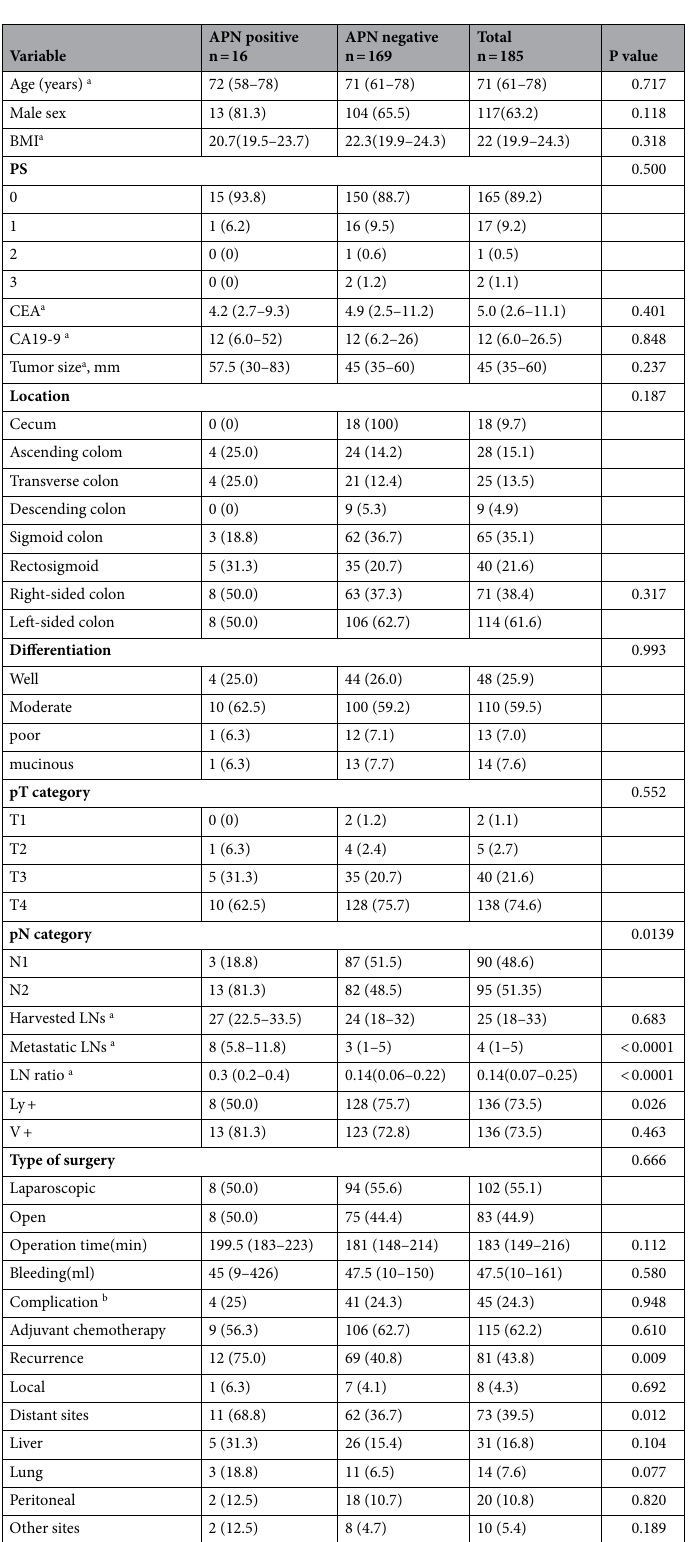
Table 1. Correlation between the APN metastasis and the clinicopathologic factors. Values in parentheses are percentages, unless indicated otherwise; a Values are median (IQR: first quartile—third quartile). BMI: body mass index, calculated as weight in kilograms divided by height in meters squared, PS: performance status, CEA: carcinoembryonic antigen, CA19-9: carbohydrate antigen 19-9, LN: lymph node, LN ratio: the number of metastatic lymph nodes divided by the total number of dissected lymph nodes, Ly+: lymphatic involvement, V+: vascular invasion. b Clavien-Dindo classification grade ≥ II, within 30 days after